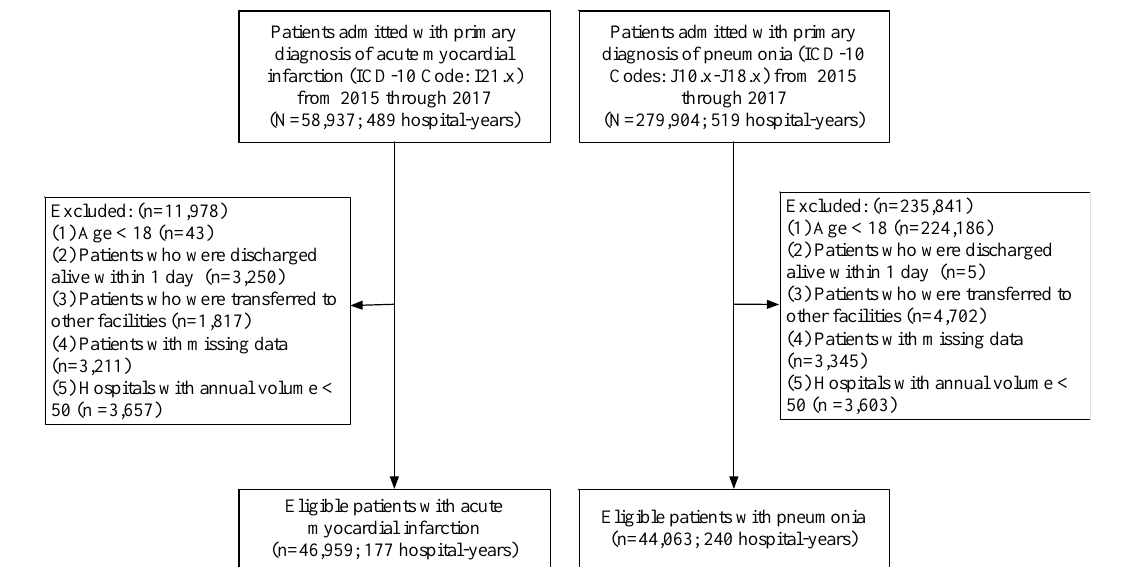
Figure 1. Flow diagram of the processing of patient-level data.